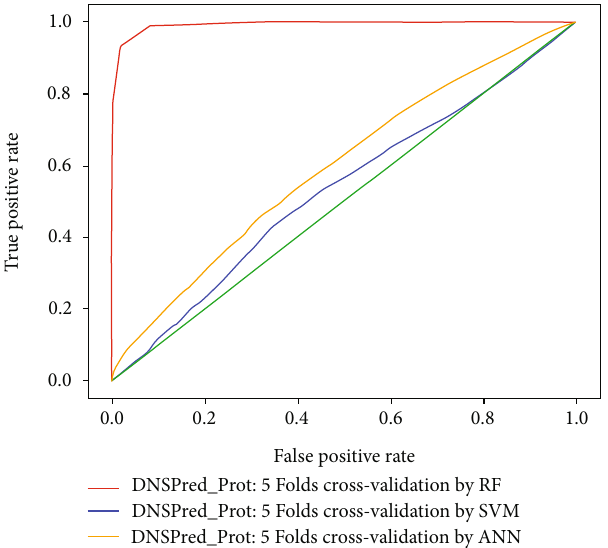
Figure 7: ROC comparison for 5-fold